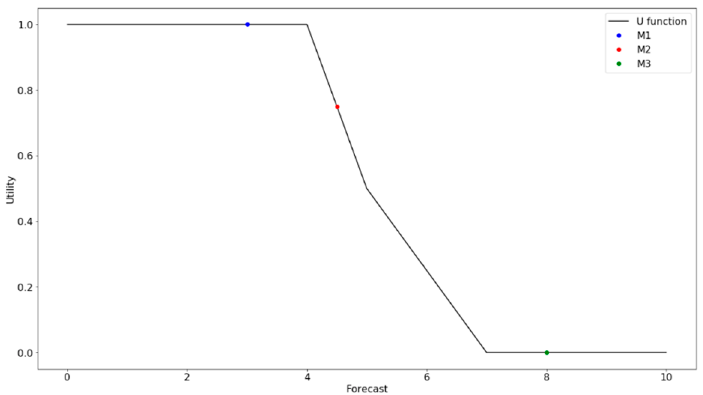
Figure 3. Stakeholder-defined utility as a function of a key hydrologic forecast. The forecast utility is shown as points for three models: M1 ; M2 ; and M3 .